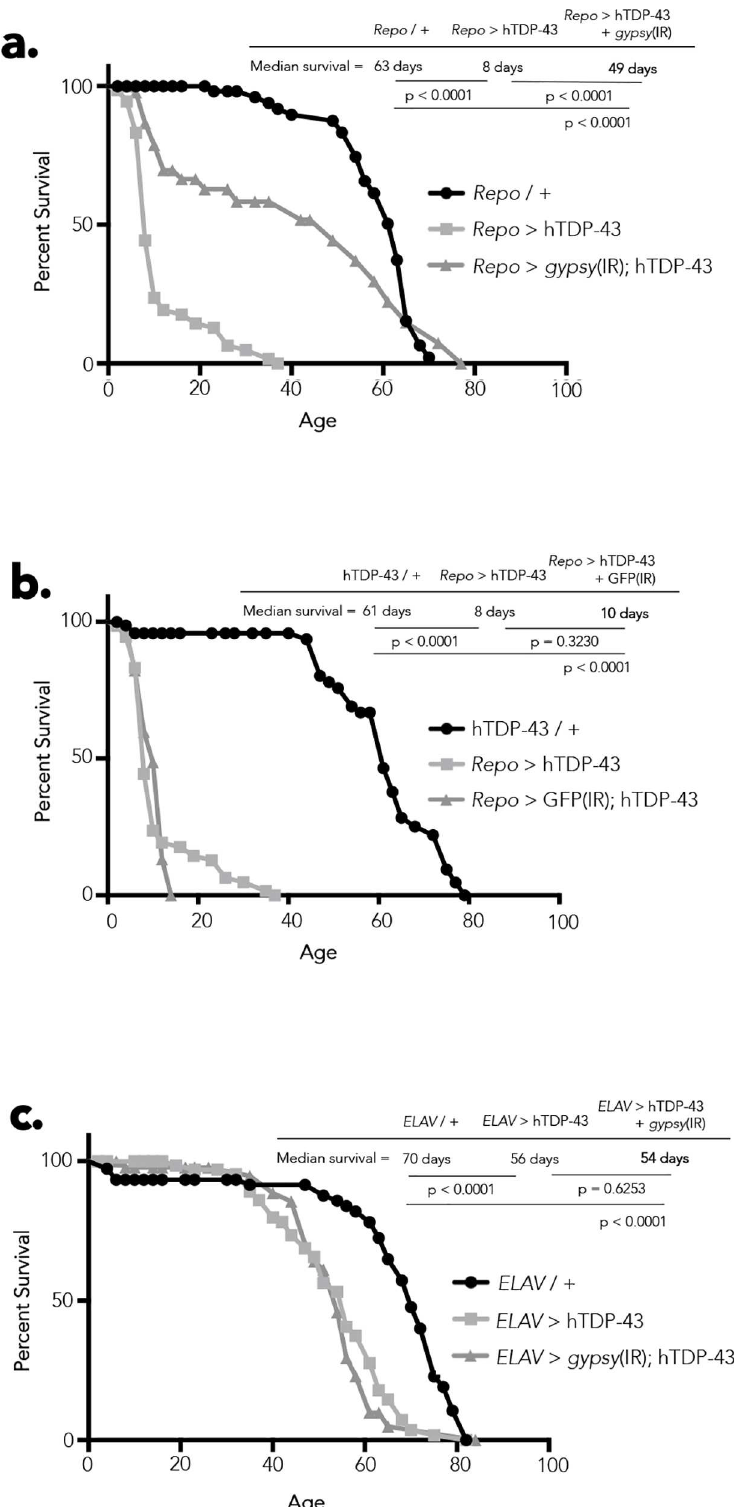
Fig 4. gypsy ERV expression contributes to hTDP-43 mediated toxicity. (A) Lifespan analysisshows that co-expression of gypsy (IR) ( Repo > gypsy (IR)+ hTDP-43) partially rescues the lifespandeficit